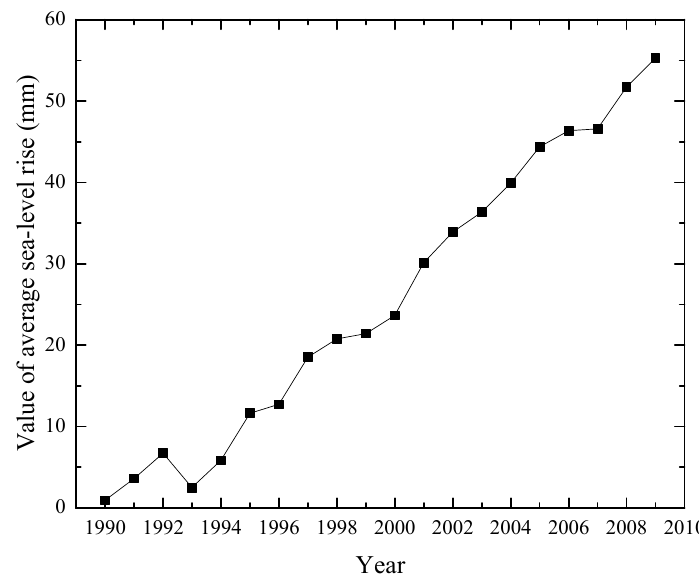
Figure 3. Global average sea level rise from 1990 to 2009 (Data from Reference [34]).